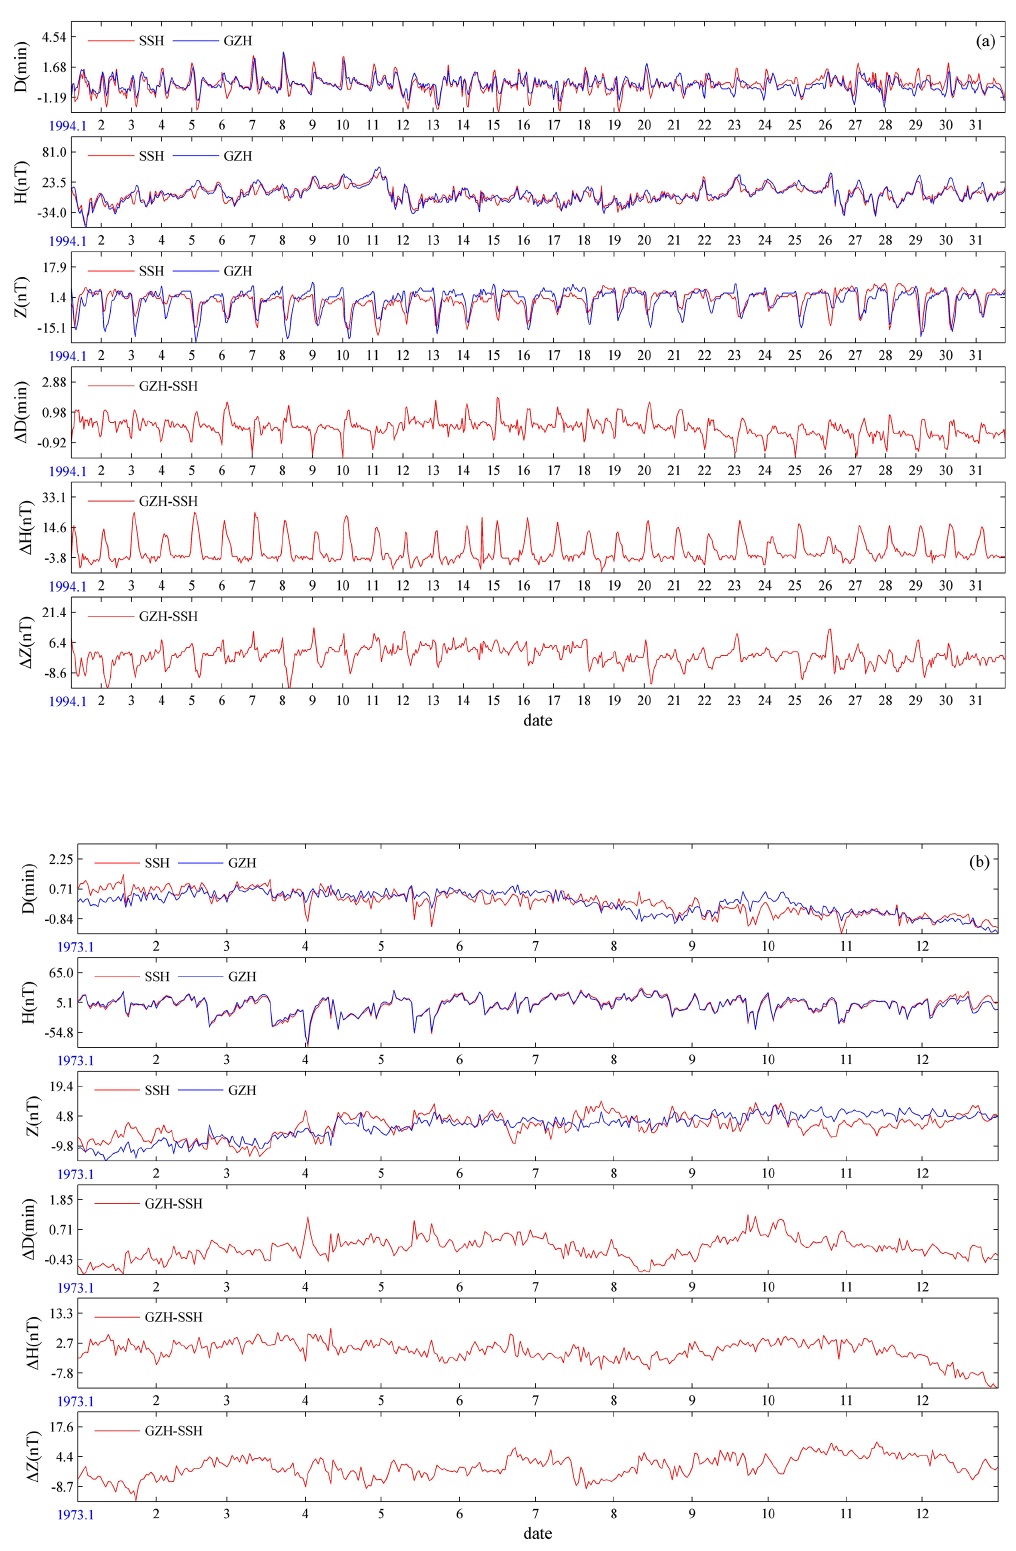
Figure 14. AHMVs, ADMVs and their difference curves of the SSH and GZH observatories. (a) AHMVs and their difference curves. (b) ADMVs and their difference